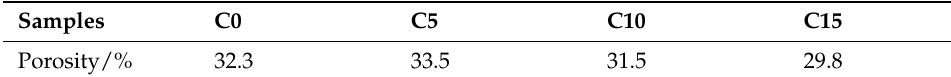
Table 3. The open porosity of green bodies.